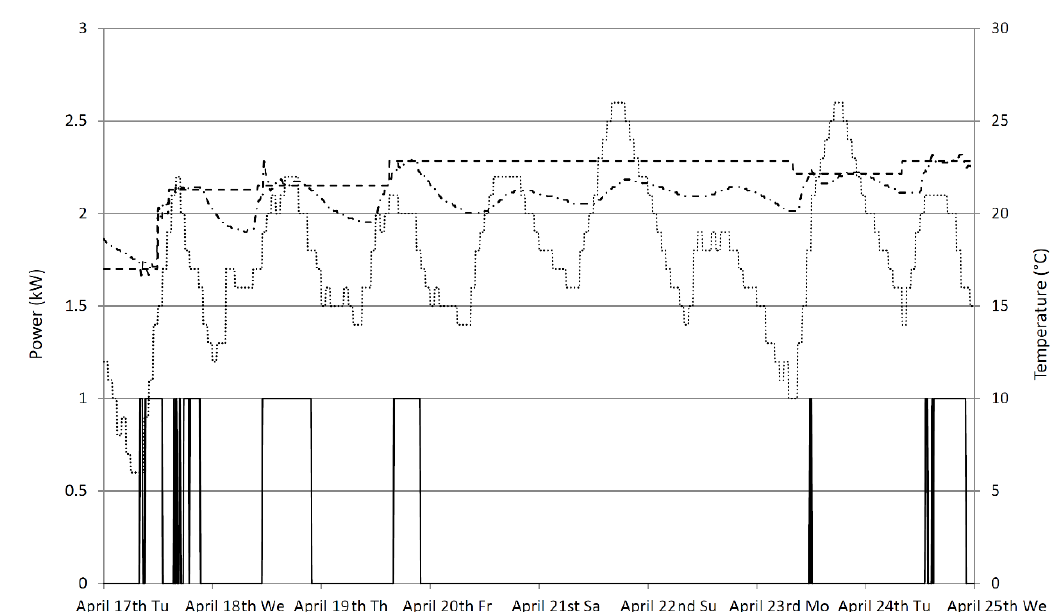
Figure 9. CL-5-Lab 2.3 AHU ventilation operation with the EEM.